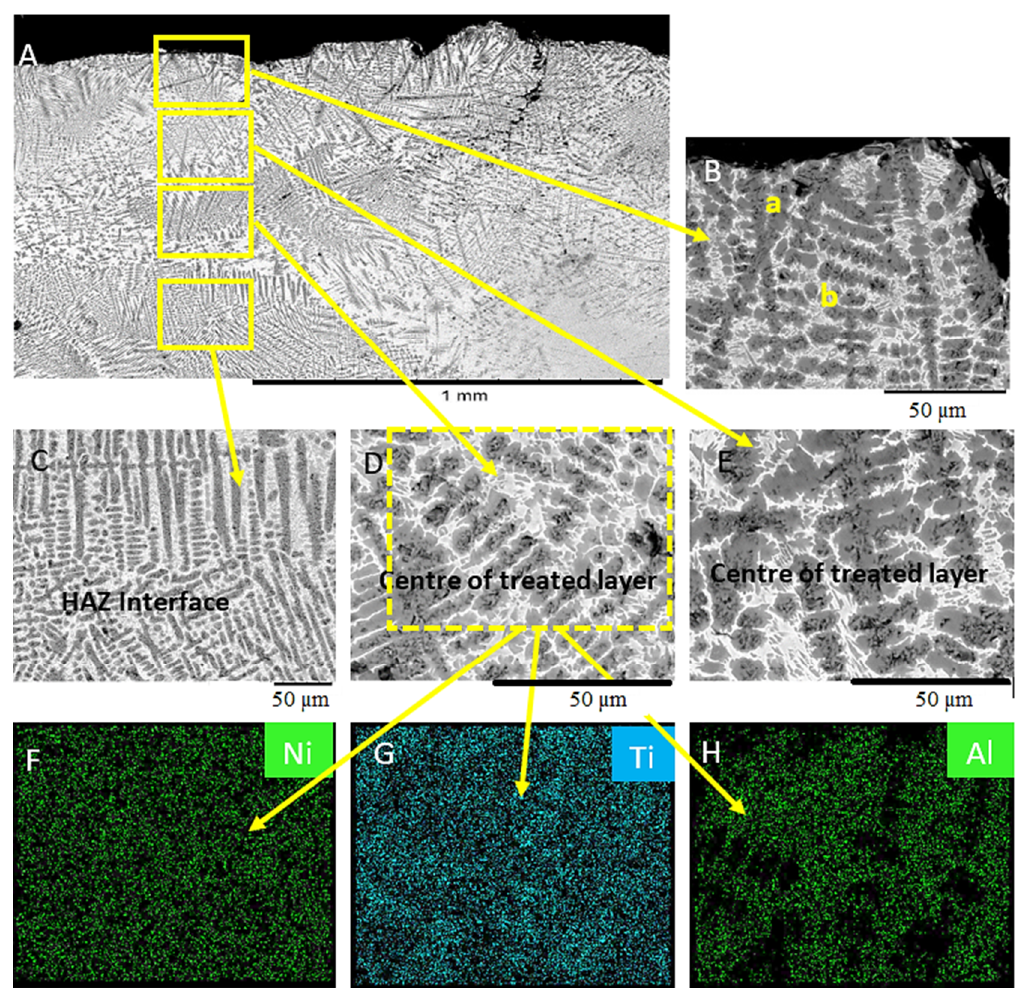
Figure 2. SEM micrographs of the uncoated Ti-6Al-4V surface melted with Gas Tungsten Arc Welding at 50A. ( A ) Width of the treated surface layer. ( B ) Detail microstructure of the top layer. ( C ) Detail microstructure within the heat-affected zone (HAZ). ( D ) Detail microstructure of below the centre of the treated layer. ( E ) Detail microstructure above the centre of the treated layer EDS maps. ( F ) Nickel, ( G ) Titanium, ( H ) Aluminium.